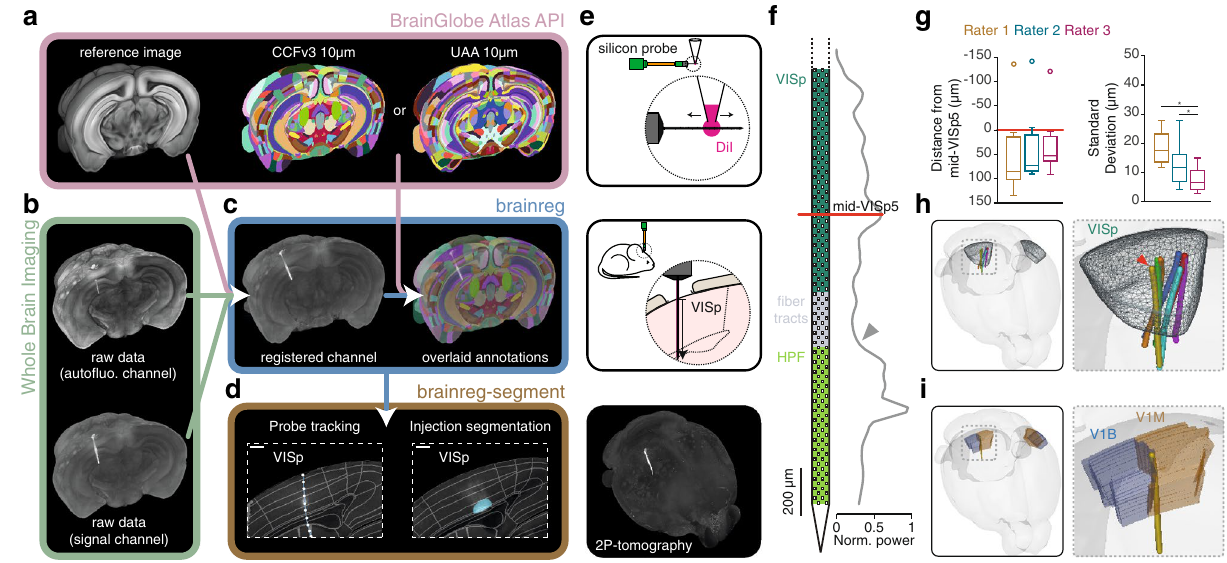
Figure 1. Overview of the brainreg/brainreg-segment workflow and validation of probe track tracing . ( a ) Atlas data including the reference anatomical image and the brain region annotations are sourced from the BrainGlobe Atlas API and used for image registration. Multiple atlases, such as the Allen Mouse Brain Common Coordinate Framework version 3 (CCFv3) and the Unified Anatomical Atlas (UAA) are supported. ( b ) Multichannel (e.g., labelled signal channel and a secondary autofluorescence channel) whole-brain microscopy data can be processed directly by brainreg without pre-processing (other than stitching). ( c ) Brainreg registers the sample data to the atlas reference image (and vice versa), allowing brain region annotations to be overlaid upon the raw data. ( d ) Brainreg-segment allows manual segmentation of labelled structures such as linear electrophysiological probes and fluorescent cell populations. Scale bars = 250 μm. ( e ) Schematic of the electrophysiological probe (Neuropixels) experiment. Top: A Neuropixels probe is coated with DiI by coming into contact with a suspended drop of the dye. Middle: The Neuropixels probe is inserted in the mouse brain above the primary visual cortical region (VISp) at a depth of 1750 or 2000 μm. Bottom: Projection of a whole- brain image (red channel) acquired with serial two-photon tomography, showing the DiI signal left by the Neuropixels probe. ( f ) Schematic of the probe and plot of the normalized Local Field Potential (LFP) power (500–1250 Hz) against depth. The red line shows the depth of the cortical LFP power peak, indicating the position of the middle of layer 5 (mid-VISp5). The grey arrowhead indicates the increase in LFP power when entering the hippocampal formation. ( g ) Left: Box plot showing the distance from landmark (mid-VISp5) for each rater (n = 7 per rater; positive distances are towards the pia). Right: Box plot showing the standard deviation of each rater (n = 7 per rater). ( h ) Rendering of the position of all the probe tracks (lines) within VISp (wireframe). Red arrowhead indicates the probe track shown in panel i. ( i ) One probe track (yellow) was identified as crossing the monocular primary cortex (V1M, brown) and the binocular primary cortex (V1B, blue)